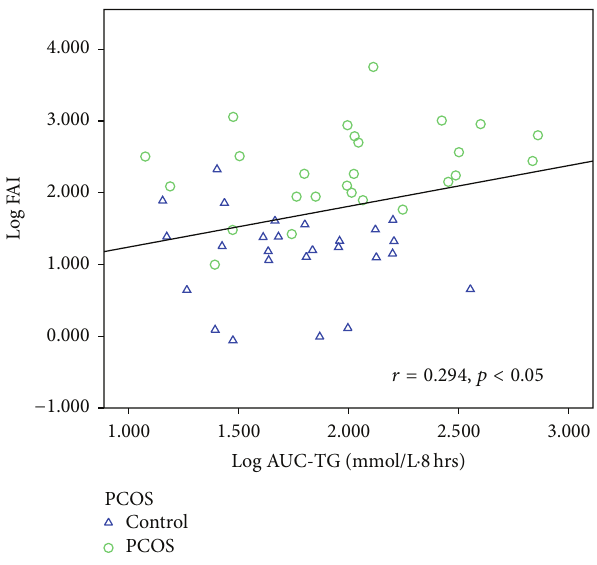
Figure 7: Correlation between AUC-TG and androstenedione.